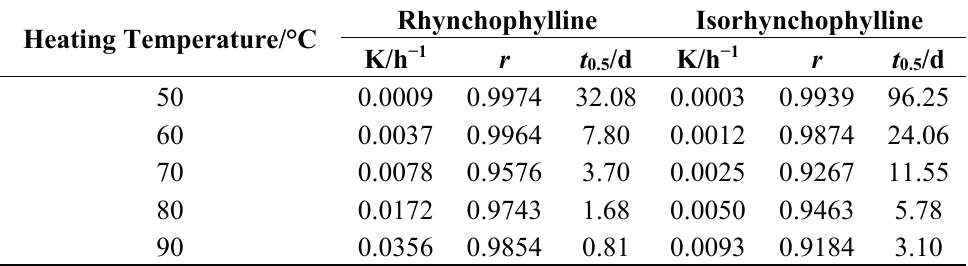
Table 1. Kinetic parameters of rhynchophylline and